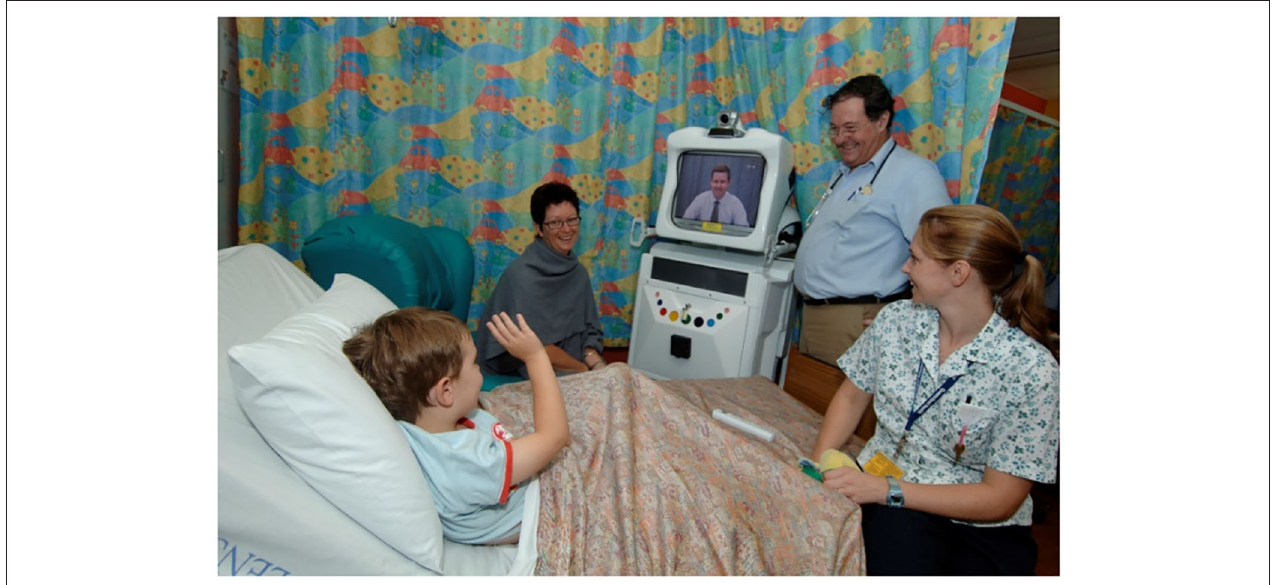
FIGURE 1 | Wireless (robot) videoconference system used for bedside consultations in regional pediatric